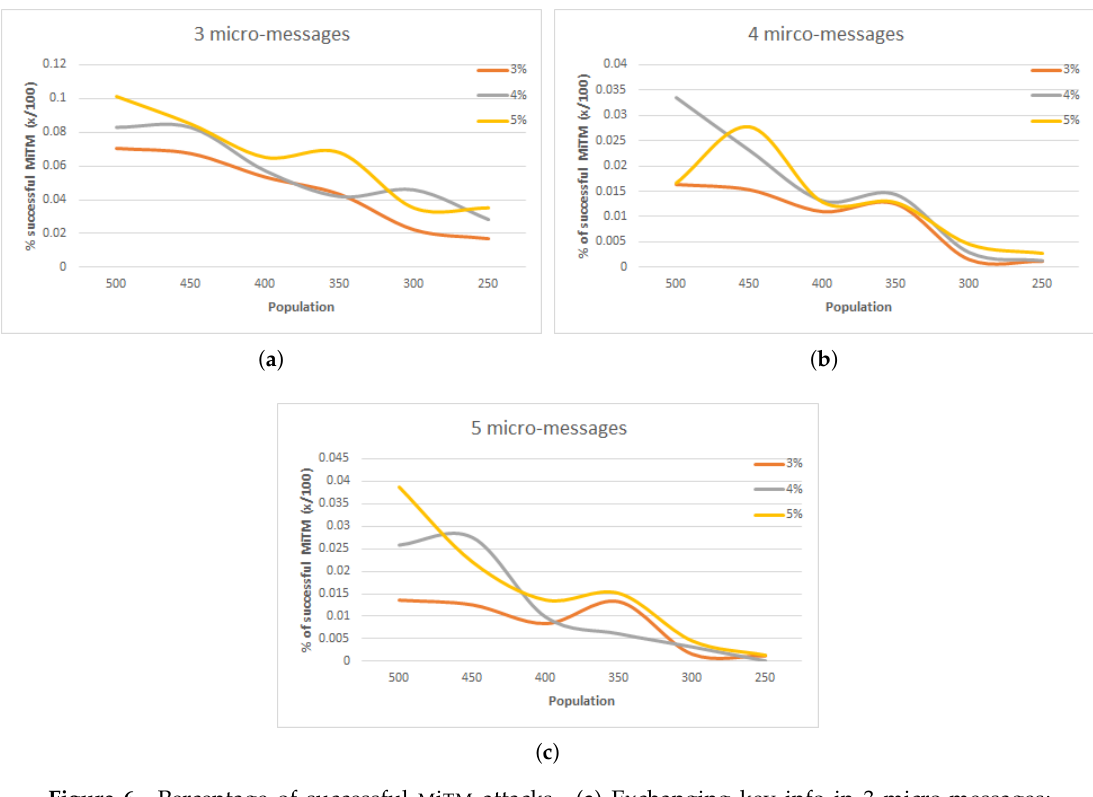
Figure 6. Percentage of successful M i TM attacks. ( a ) Exchanging key info in 3 micro-messages;